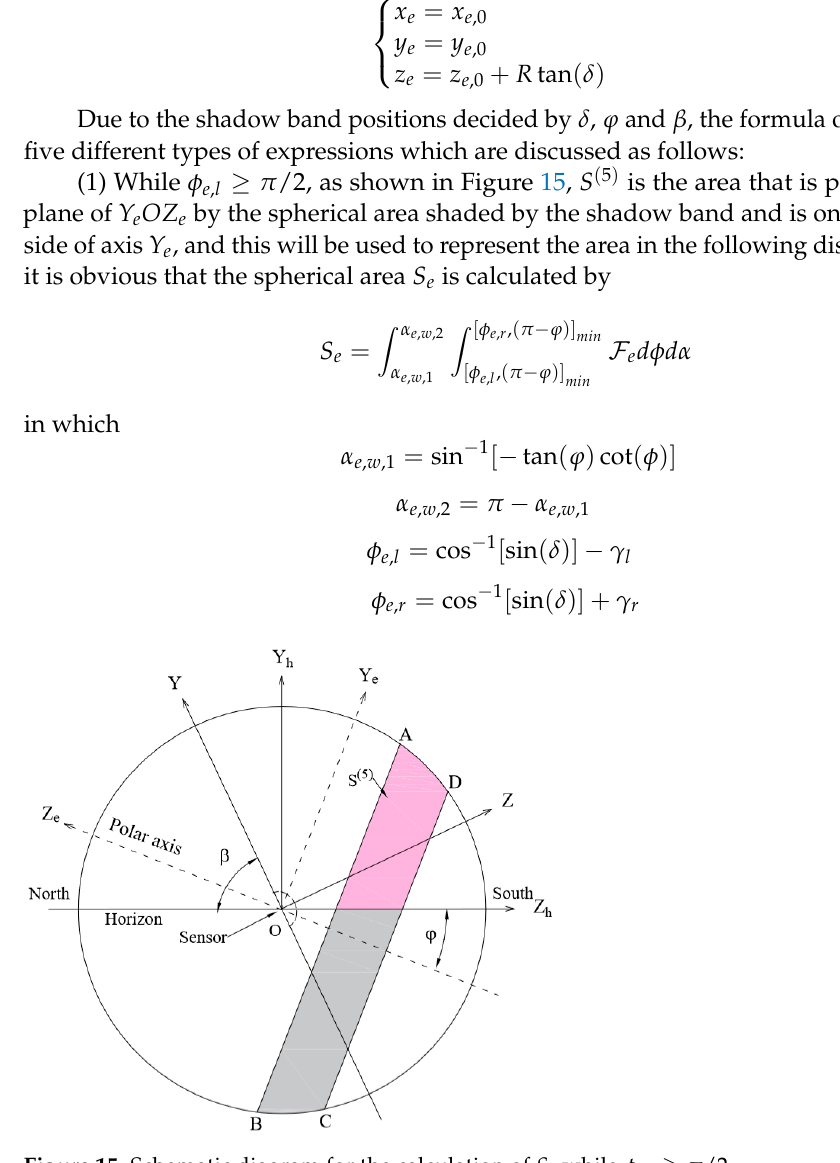
Figure 15. Schematic diagram for the calculation of S e while φ e , l ≥ π